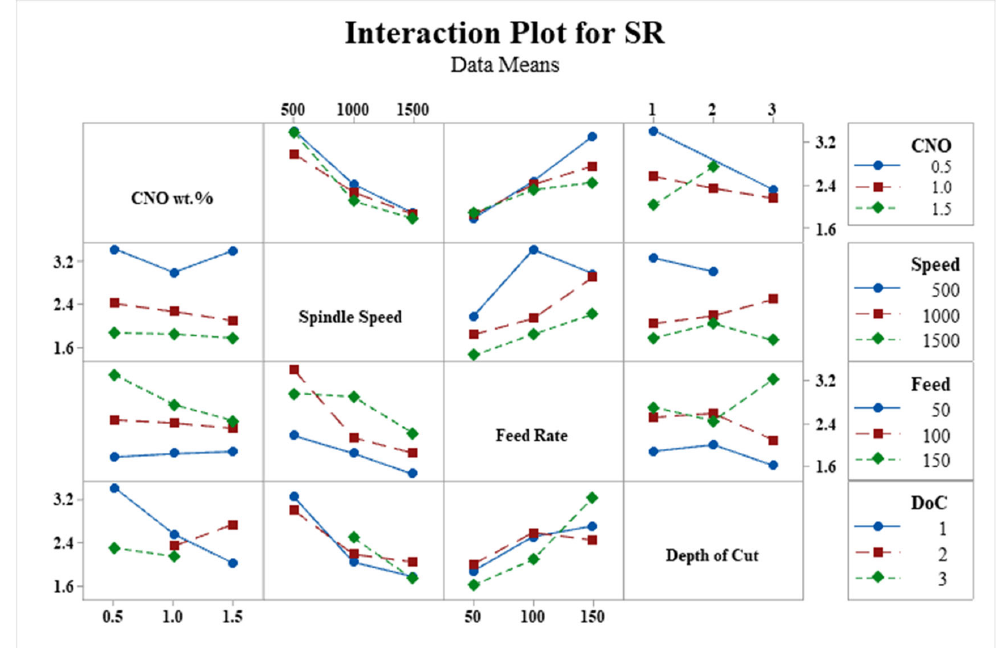
Fig. 6. Interaction Plot for Surface roughness